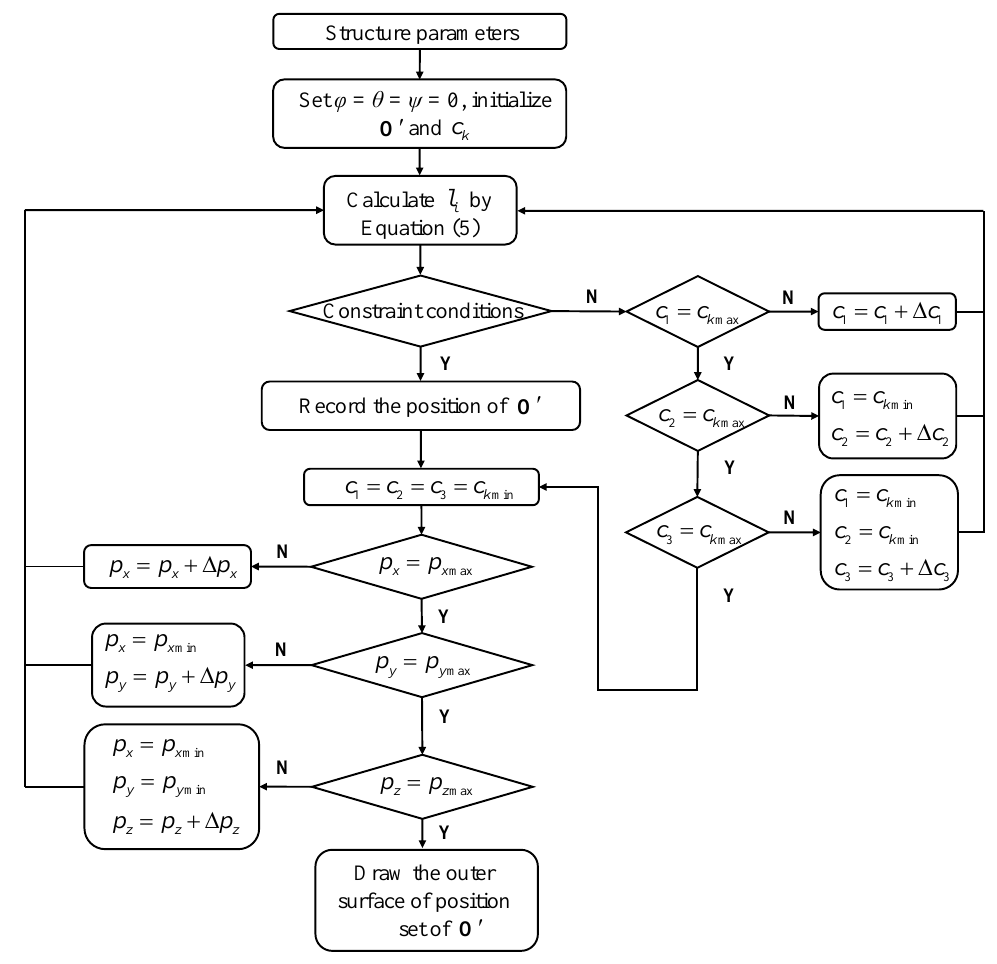
Figure 3. The calculation framework for solving the position workspace of RPRI.